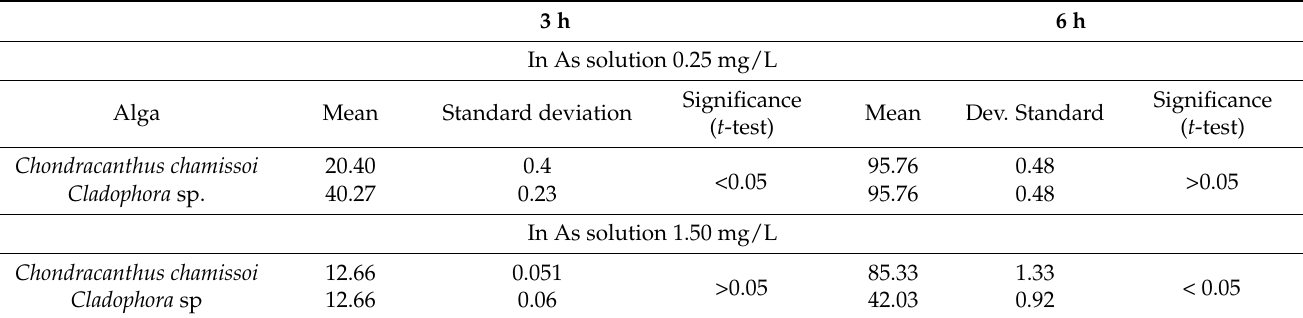
Table 2. Comparison of means of the biosorption percentages of Chondracathus chamissoi and Cladophora sp. at 3 and 6 h of treatment in As solutions at concentrations of 0.25 and 1.50 mg/L. 3 h 6 h In As solution 0.25